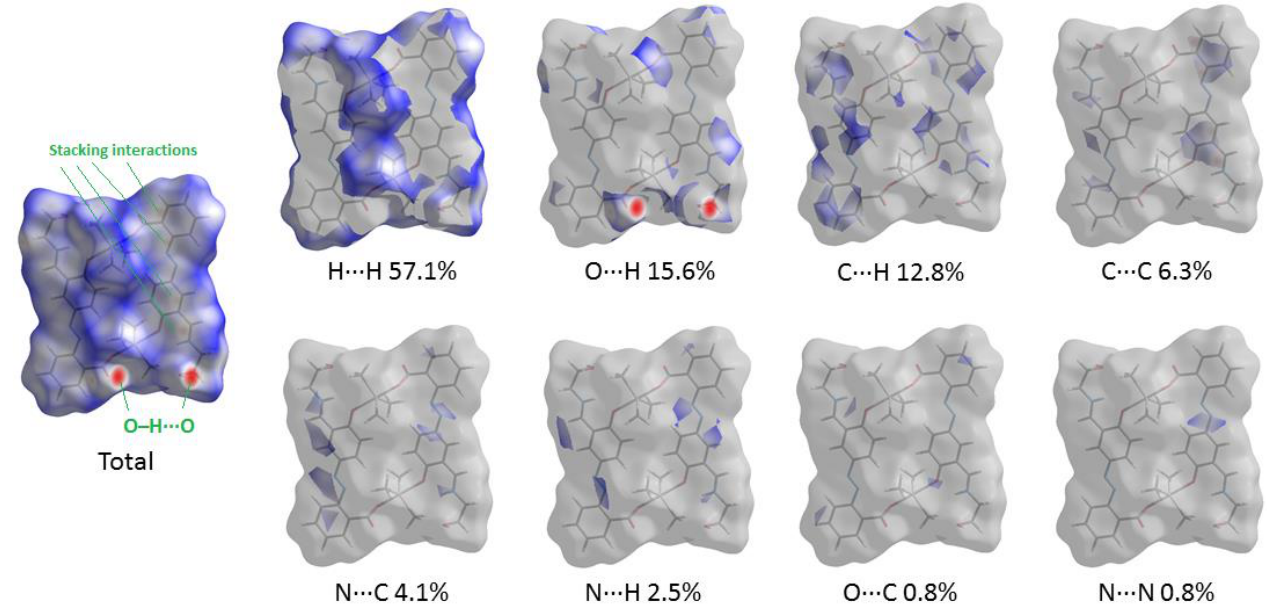
Figure 5. Results of a Hirshfeld surface analysis for the X-ray structure 1 .